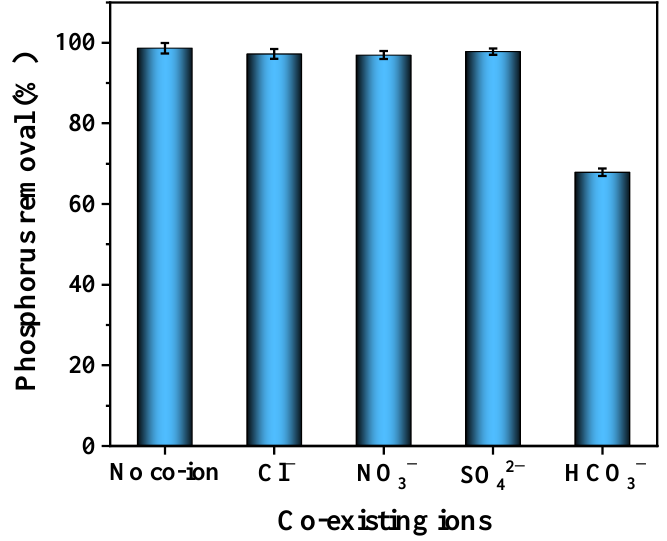
Figure 5. The effect of co-existing ions on phosphorus adsorption.